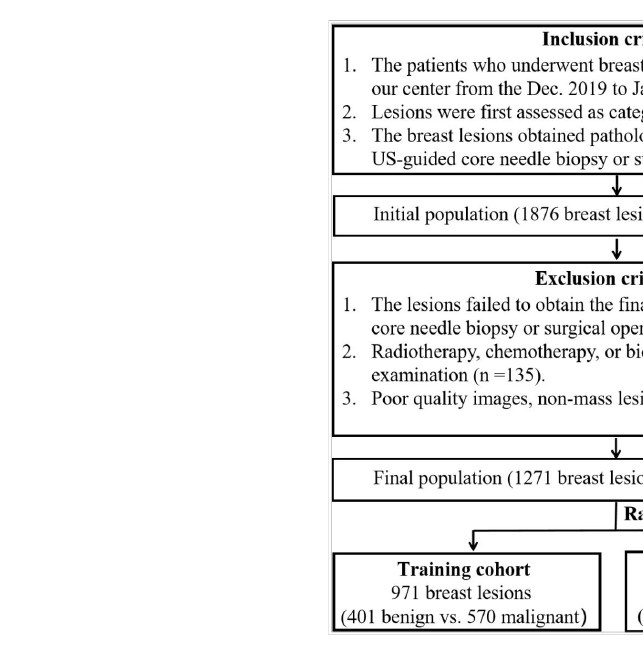
average stiffness of the lesion including the peritumoral tissue (Figure 2). All SWE images were taken from the longitudinal and transverse section of the breast lesions, and two senior breast radiologists with more than eight years of clinical experience performed all of the SWE examinations. The radiologists in this study were blinded to the patients ’ clinical data and pathological